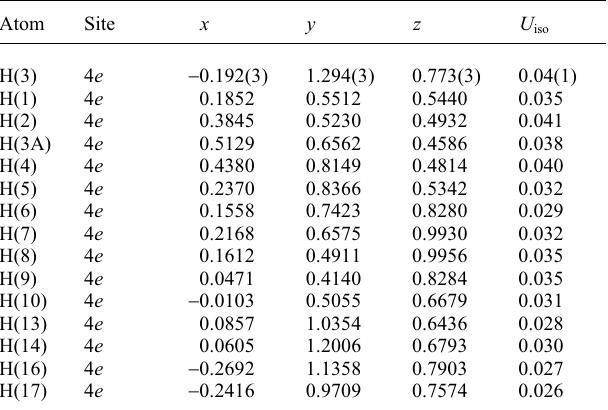
Table 2. Atomic coordinates and displacement parameters (in Å 2 )